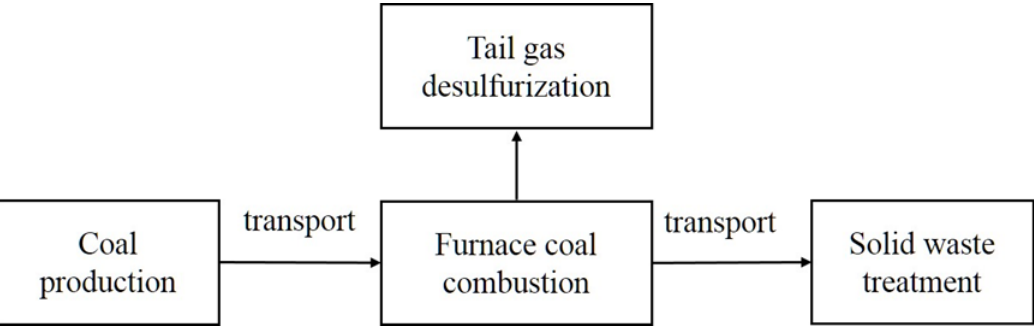
Figure 1. System boundary diagram of a coal-fired power plant.